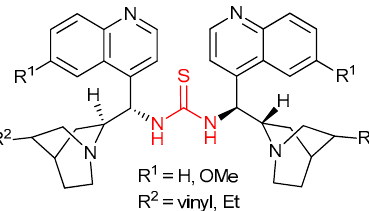
Figure 16. Bis-alkaloid thioureas prepared by Song’ group [251].